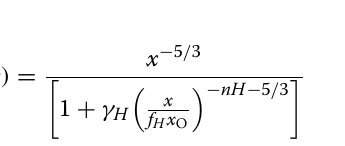
Fig. 5 Non-dimensional TKE dissipation rate plotted against 2 k B b . Top left: Base case with abyb Top right: Case with abyb 10, Lby2b 0.001 (nonzero altitude). Bottom left: Case with abyb = = with abyb 10, Lby2b 5 (nonzero altitude and wind). Solid line is the numerical model, the dotted line is Weinstock and dashed line, White et al. = = Hocking 0, waves 0 and fK 1, and the upper limit of integrations is ∞ , in the above simulations. If instead Bragg wavenumber were imposed = = = as the upper limit, the model would depart from Weinstock values at high values of k B (2 b ). The transition value of k B (2 b ) between Weinstock and White et al. formulations depends very much on the values of L /2 b and 2 a /2 b . Because C K asymptote exactly to the two limits (see Appendix